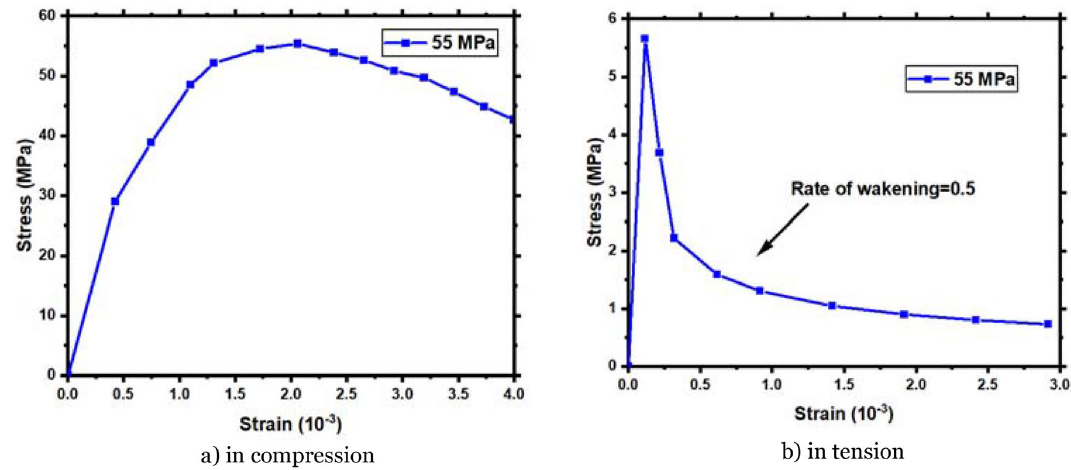
Figure 2. Stress–strain behavior of the